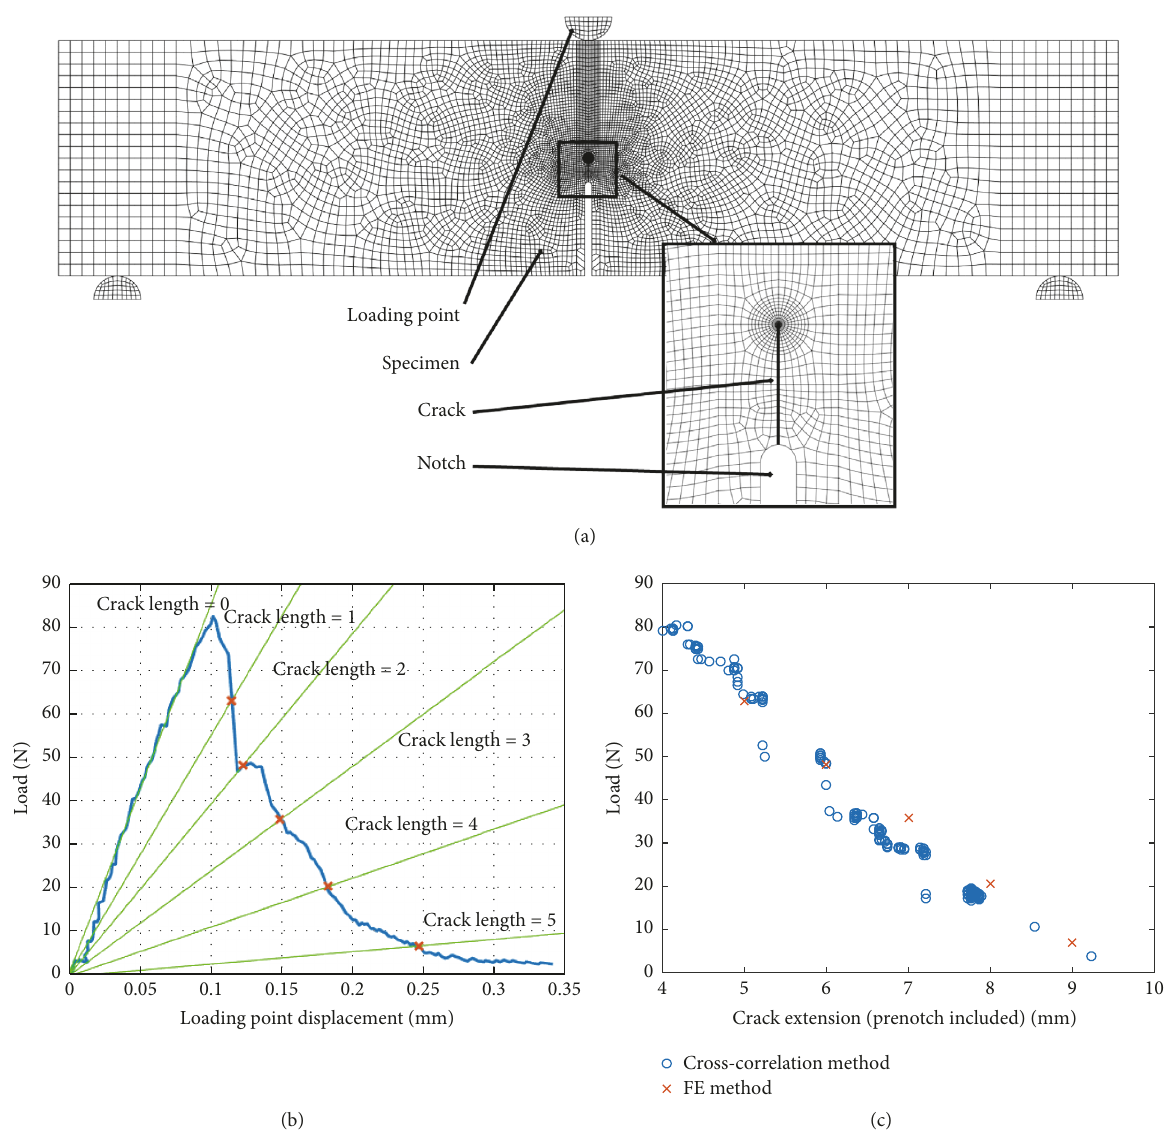
Figure9:FEsimulation:(a)FEmodel,(b)FE-predictedload-displacementcurves(green)formodelswithdifferentcracklengthsintersecting with the experimental load-displacement curve (blue), and (c) FE and cross-correlation results for the load-crack extension